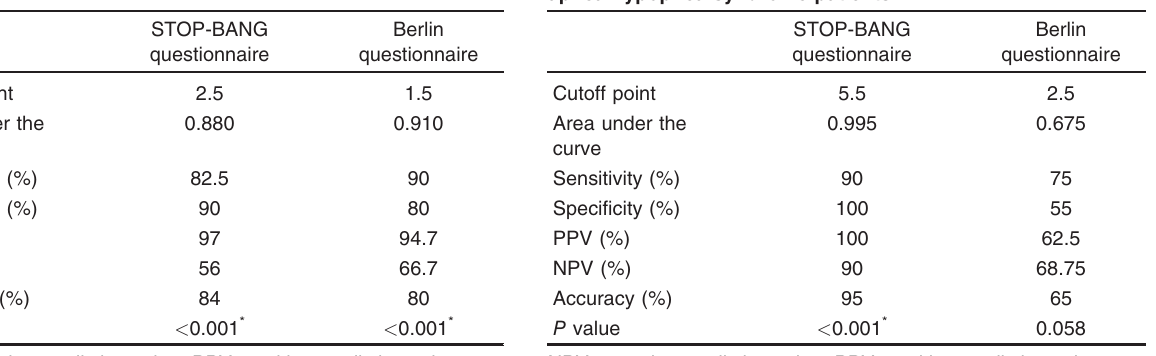
Table 4 Value of STOP-BANG questionnaire and Berlin questionnaires for the prediction of severe obstructive sleep